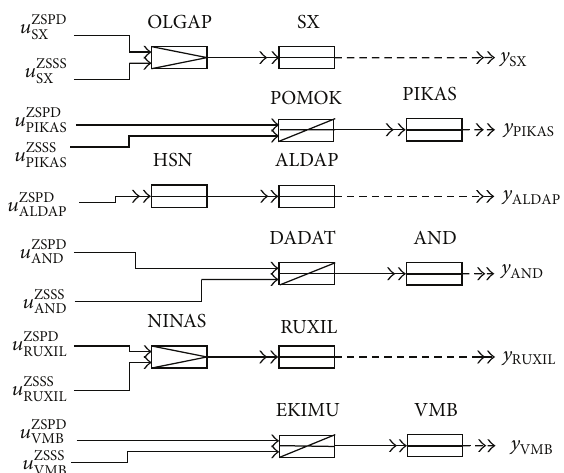
Figure 15: Synthesized departing air traffic model of the Shanghai terminal area.